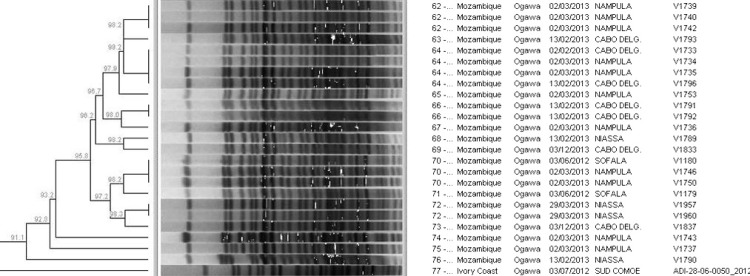
Snapshot of dendrogram of PFGE (NotI digestion) patterns for V. cholerae O1 isolates.